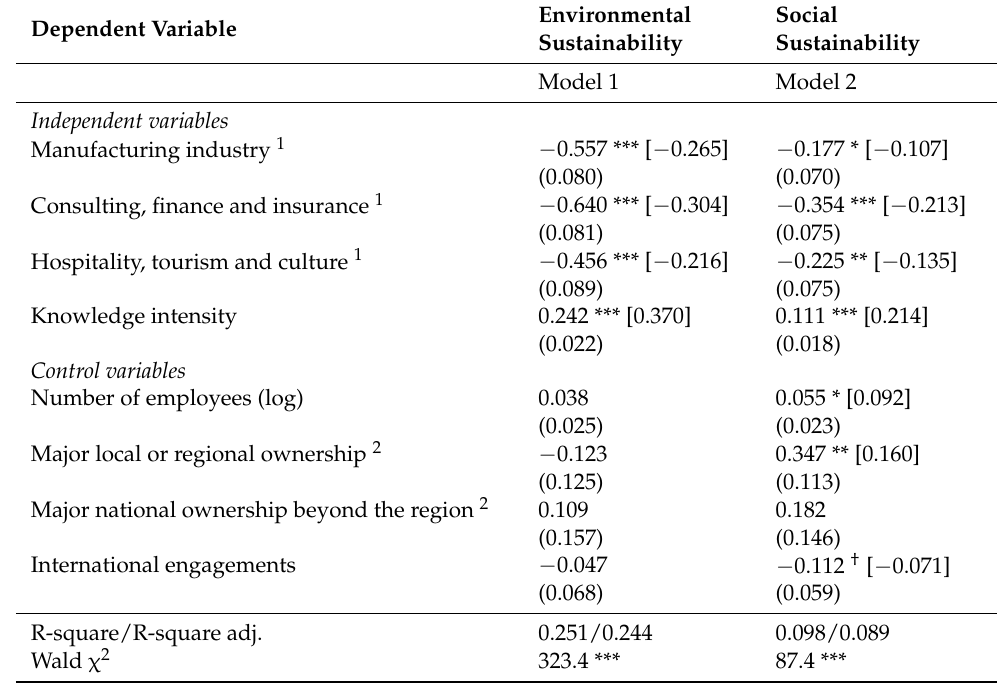
Table 2. Bootstrapped ordinary least square (OLS) regressions, including all four industries. Dependent Variable